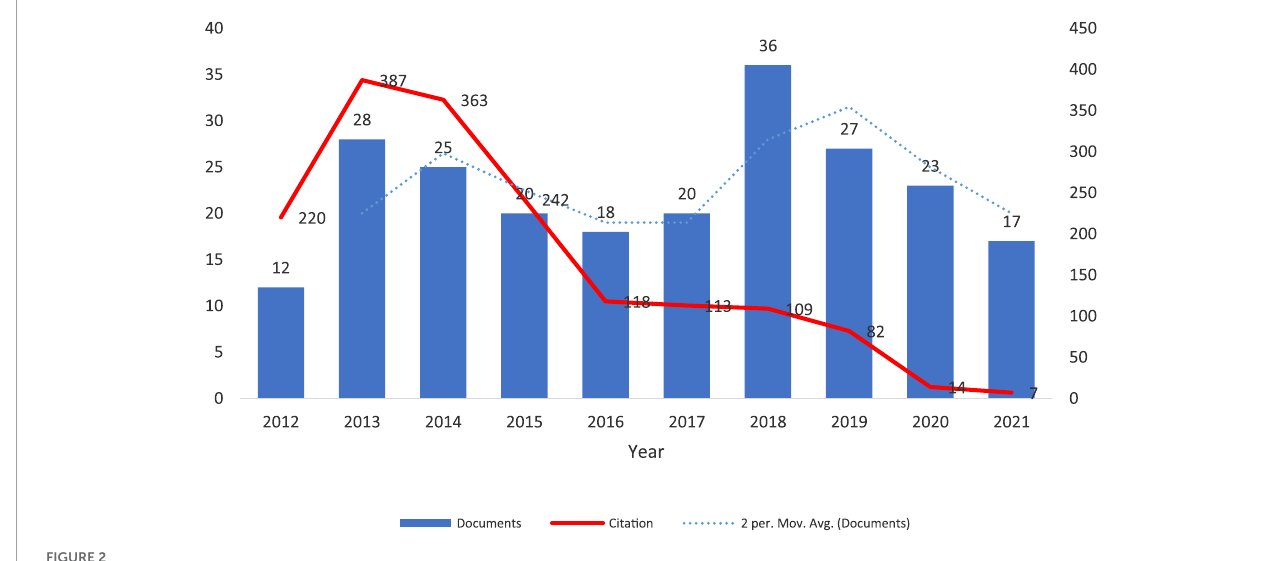
FIGURE2 The publication data in 2012–2021 with the number of documents and citations.